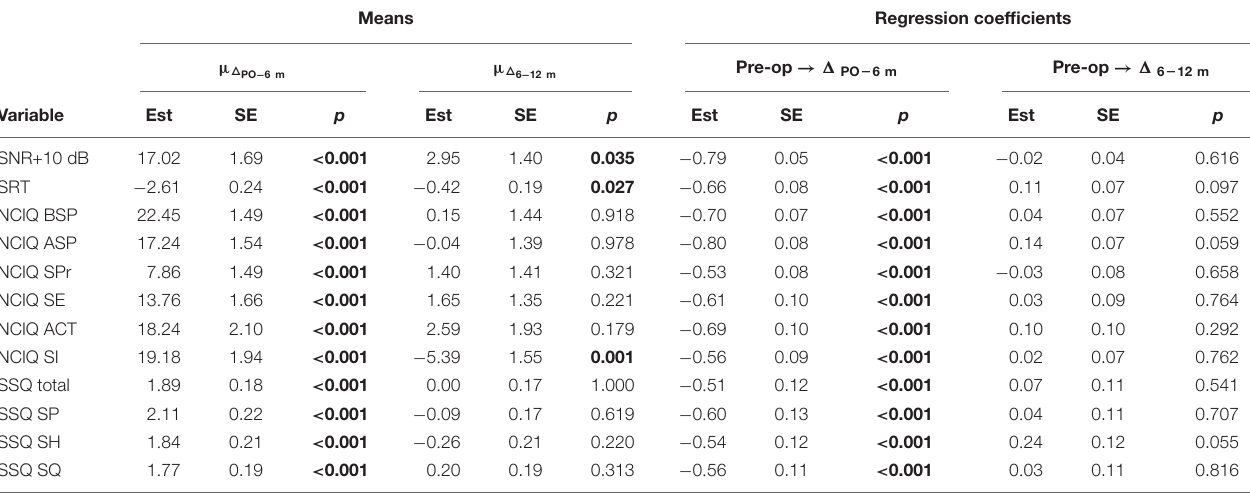
TABLE 2 | Unstandardized means of change and regression coefficients for preoperative adjustment of change scores, and standardized covariance parameters in univariate latent change score models. Means Regression coefficients